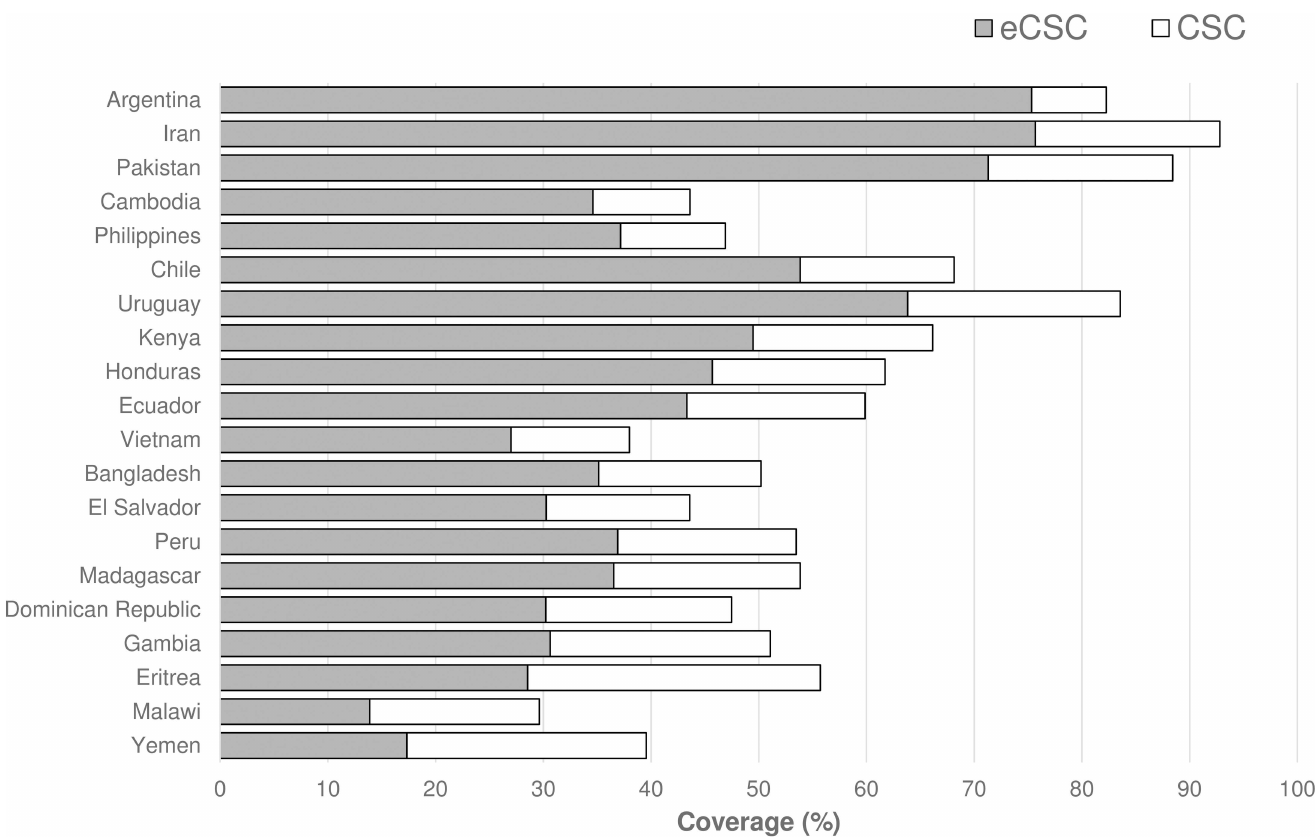
Fig 2. Cataractsurgical coverage(CSC) and effectivecataractsurgical coverage(eCSC; persons < 6/60, %) in 20 countries, 2005–2013. Arranged in ascendingorder of relative gap betweenCSC and eCSC (i.e. 1 –eCSC / CSC); the gap is smallest for Argentinaand largest for Yemen.